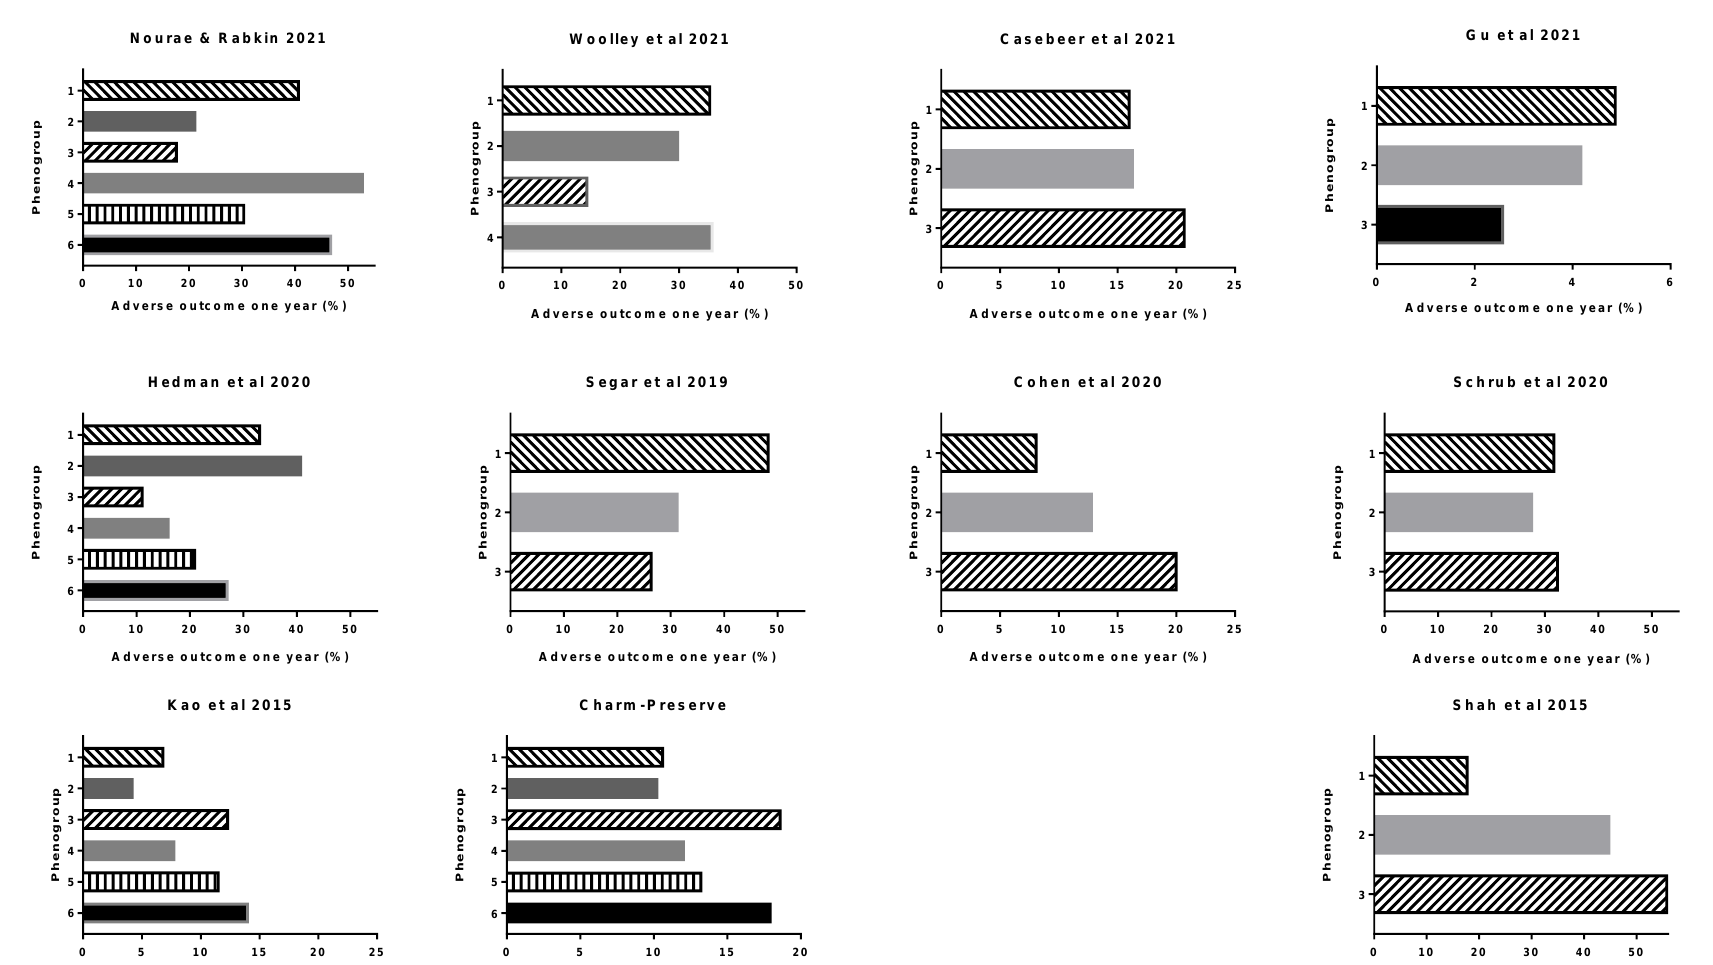
Figure 2: One year outcome in each phenogroup in each of the studies cited. The Charm-Preserve study was included in one of the